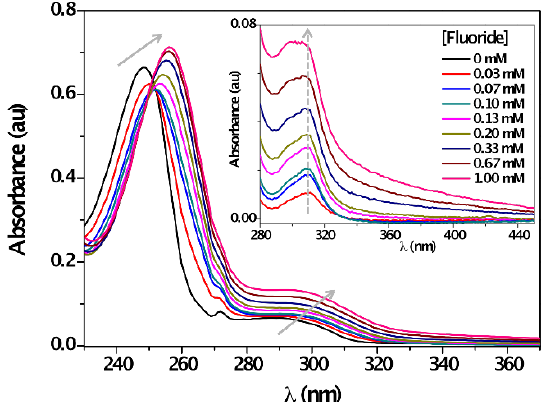
Figure 2. Absorption spectra of 1 ( c = 0.04 mM) in the absence and with increasing amounts of F¯ ( c = 0, 0.07 mM → 1 mM) in acetonitrile at room temperature. Inset: Difference UV-spectra of [ 1 + F¯] – 1 in the long wavelength region.